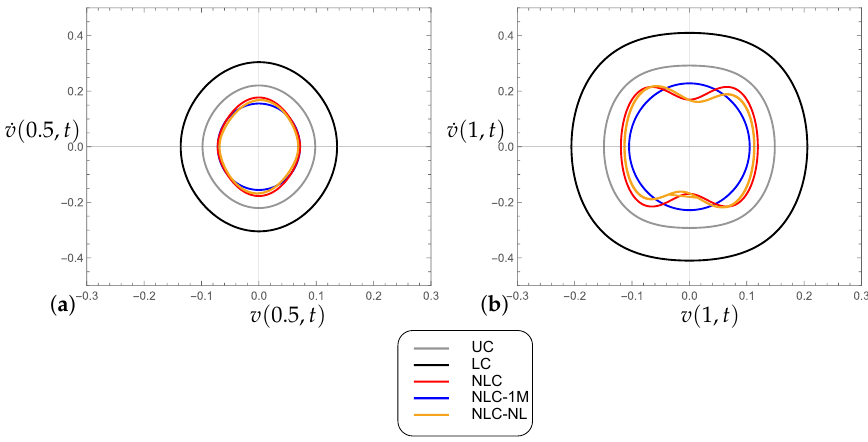
Figure 7. Phase plot for the beam for ¯ U = 1.25, σ e = 0, σ i = 0: ( a ) at s = 0.5; ( b ) at s = 1.